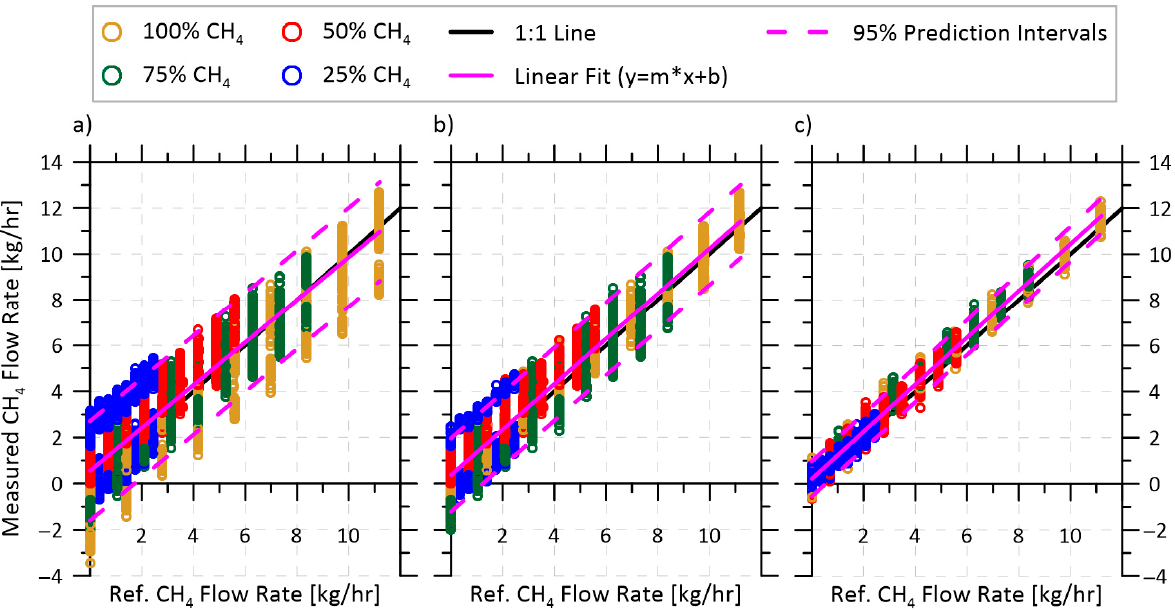
Figure 8. Achievable prediction intervals at 95% confidence when measuring methane mass flow rates in three scenarios: ( a ) extremely variable source methane volume fraction, varying from 25–100% during the measurement with an instrument zero recorded at ≥ 50%; ( b ) highly variable source where methane volume fraction varies by ± 25% (i.e., a range of 25–75% about a source initially at 50% volume fraction); ( c ) source with initially unknown and otherwise invariant methane volume fraction.